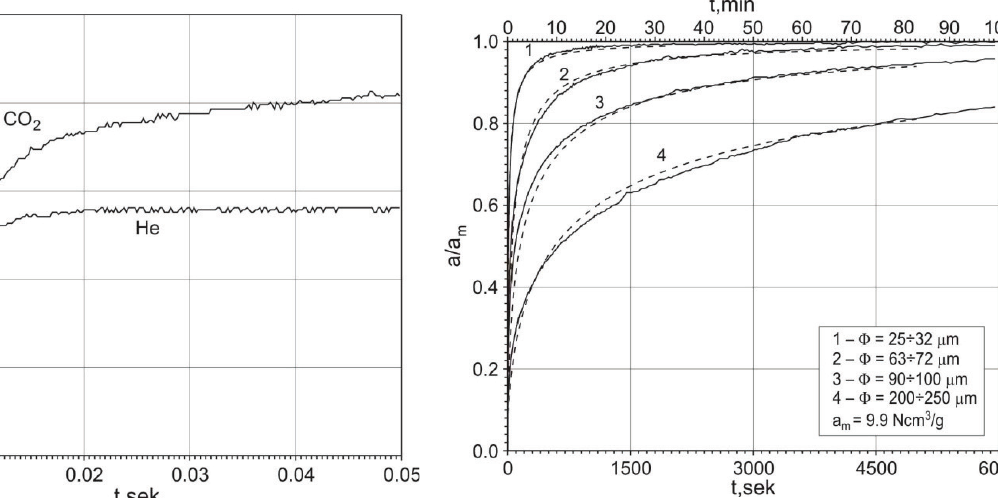
in time, p = 0.25 2 0